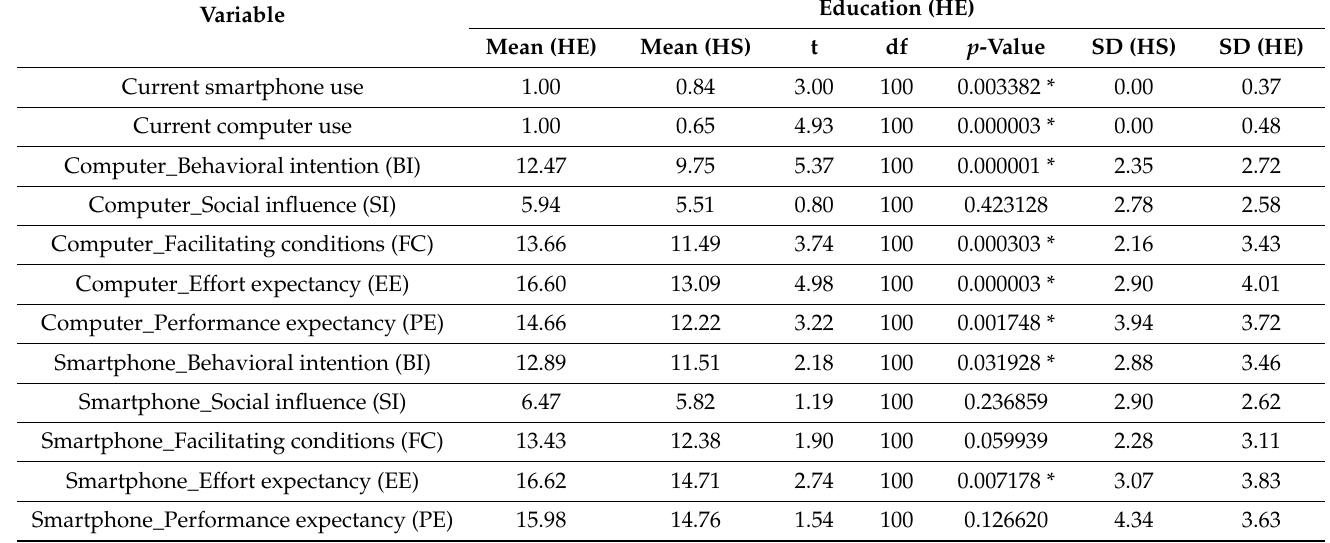
Table 5. Difference between education level groups in current technology use and technology use acceptance (T-Statistics). T-Statistics; Grouping Variable: High School Education or Less (HS) and Higher Education (HE) Variable Mean (HE) Mean (HS)